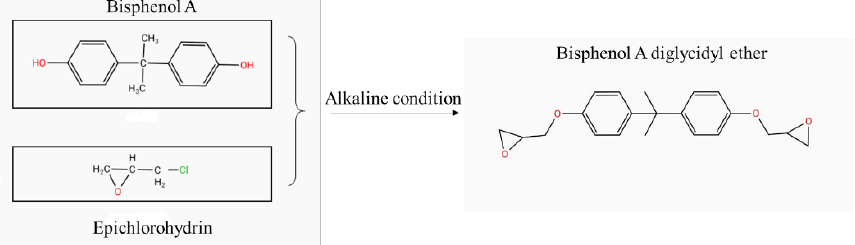
Figure 2. The reaction mechanism of bisphenol A diglycidyl ether (DGEBA).